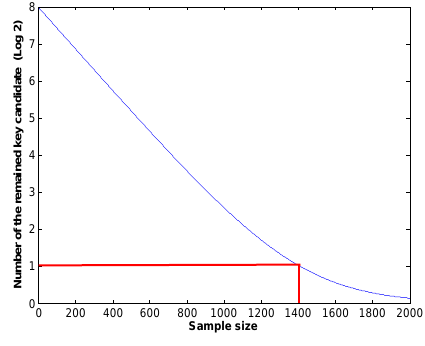
Figure 2: Relationship between log (cid:15) n and n for one element of master key where b = 8. 2 The estimation of n (when log (cid:15) n is reduce to 1) is popularly known as the coupon 2 collector’s problem [BHS94] where it needs 255 ∗ (1 / 1 + 1 / 2 + ... + 1 / 255) ’ 1561